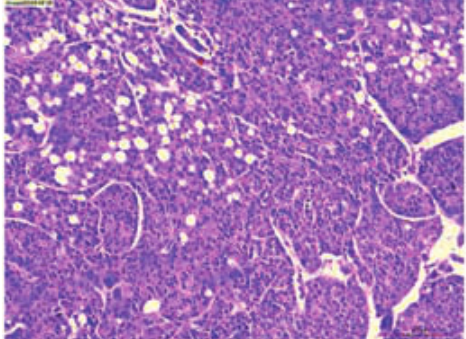
Fig. 4. Hepatoid gland epithelioma- invading neoplastic cells (arrow) into the blue stained connective tissue stroma (Masson’s trichrome x 100)